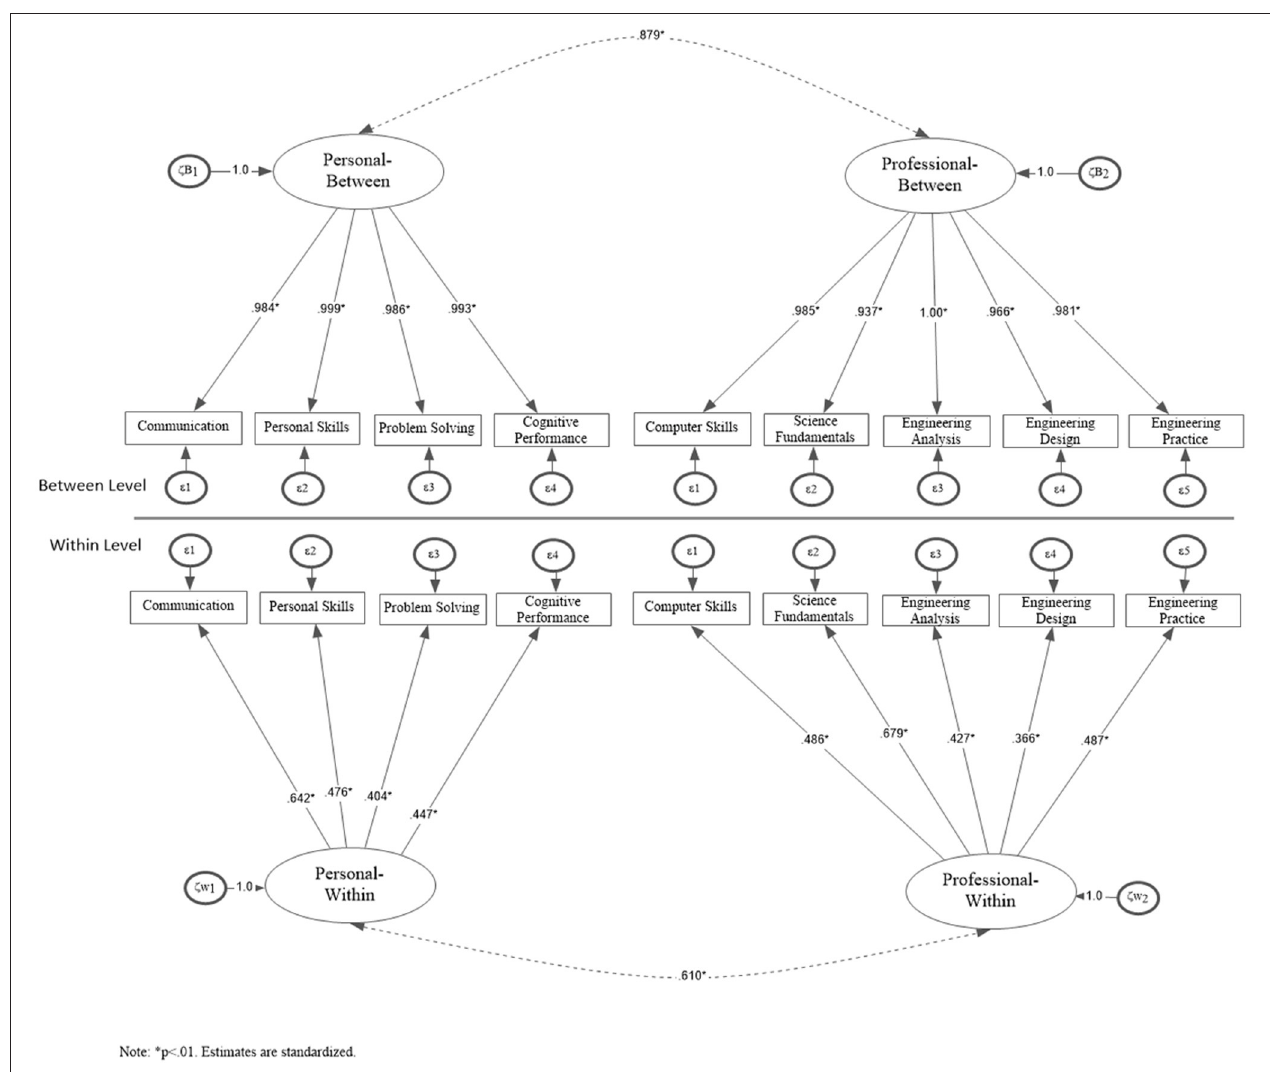
FIGURE 2 | Two-factor structure fitted at both the person (within) and university (between) levels (N w = 1696, N b = 21).